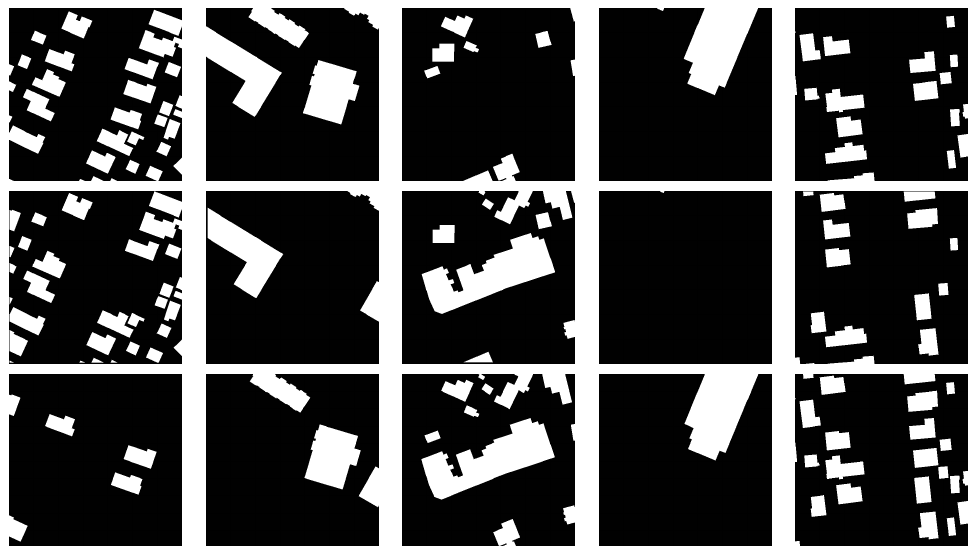
Figure 4. Examples of the simulated change detection dataset. The first row is the original building mask maps, the second row shows simulated buildings added or original buildings eliminated upon the mask maps, where the original buildings are slightly shifted according to a random parallax. The last row is simulated change labels.